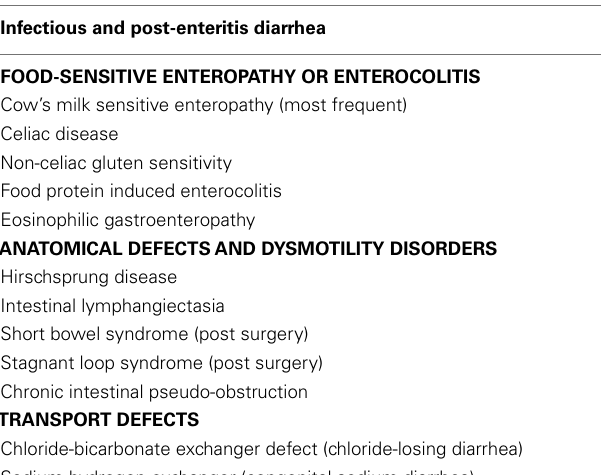
Table 2 | Differential diagnosis of early onset persistent